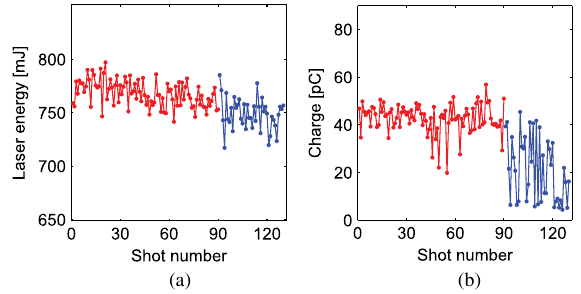
FIG. 2. Laser pulse energy delivered to the entrance of a 20 mm long, 152 μ m diameter capillary tube (a) and the corresponding accelerated charge with an energy above 40 MeV (b) as a function of shot number. The active stabilization system is on during the first 90 pulses, and thereafter off. The stability of the electron bunch charge is significantly decreased by turning this system off.